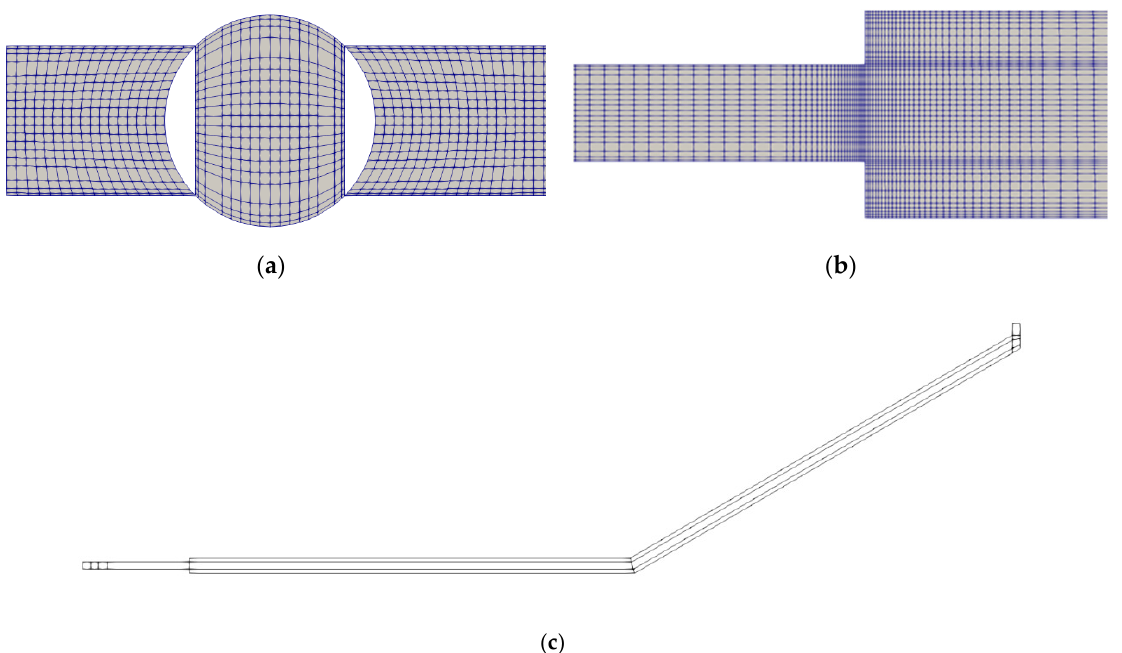
Figure 2. Details of the experimental installation: ( a ) details of the mesh in the ball valve, ( b ) details of the reduction mesh, ( c ) details of the blocks as a function of the pipe symmetry.